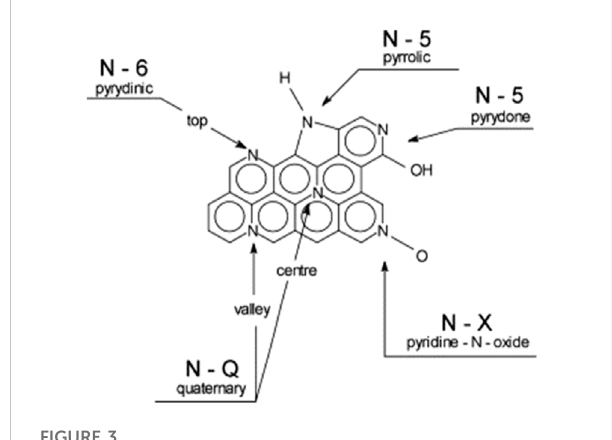
FIGURE 3 Distribution of nitrogen atoms in carbon graphene